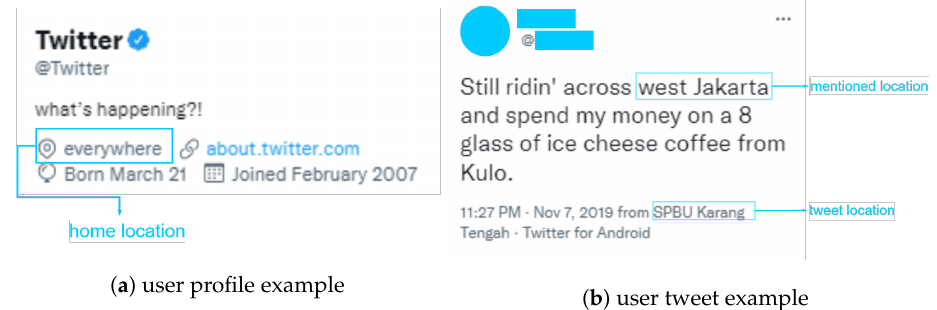
Figure 1. Illustration of home location, tweet location, and mentioned location in user profile and user tweet.